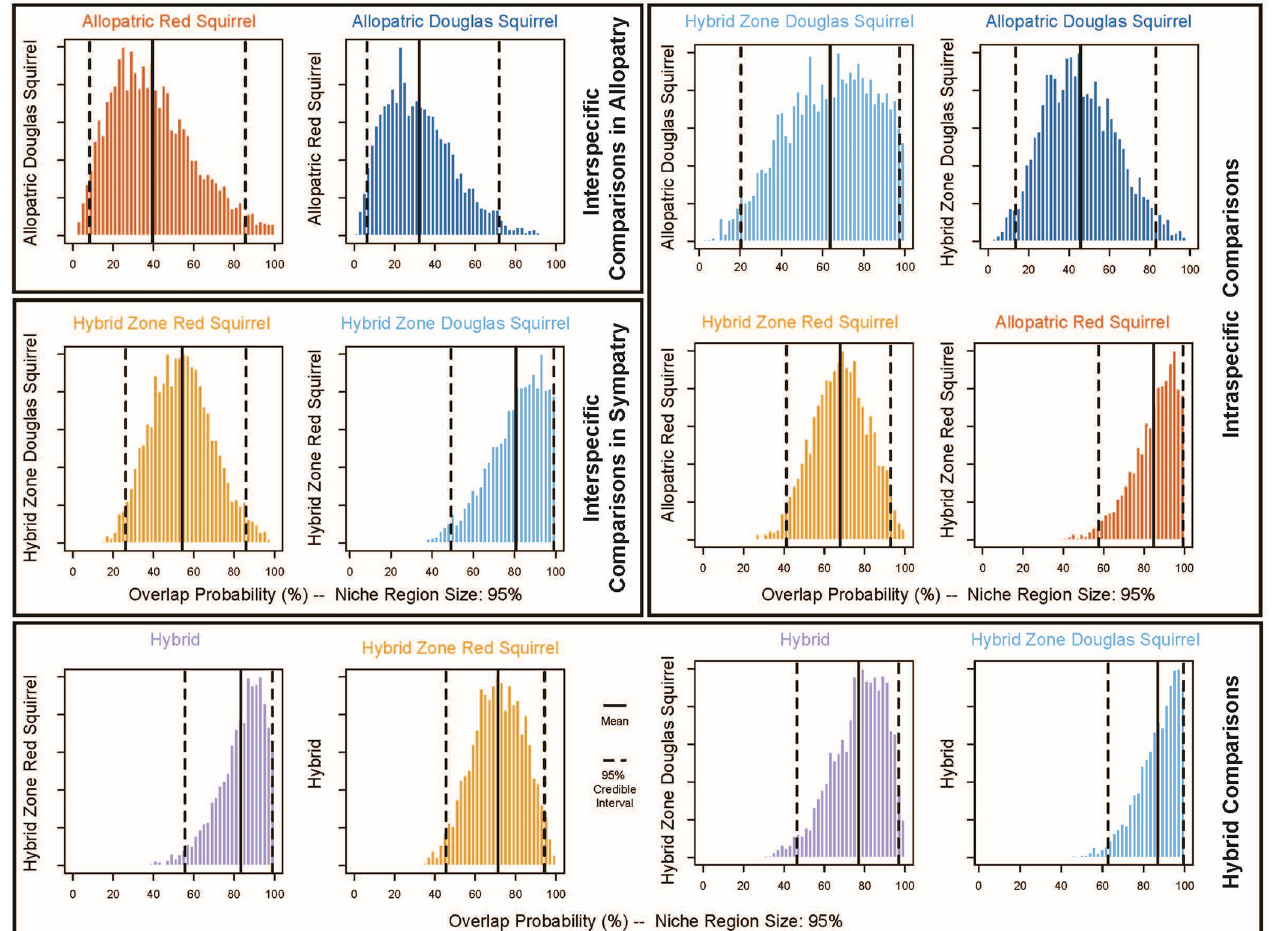
Fig 6. The probability of mandible morphospace overlap between squirrel groups for geometric morphometric principal components 1 and 2 representing shape and log10-transformed centroid size representing size. Data shown are a posterior histogram of 3000 iterations of overlap metric calculations, whereby the x-axis of each pairwise comparison is the range of overlap probabilities in percentage, and the y-axis is the frequency of that probability having been observed in the calculation. Mean overlap probability is shown as a solid black line, and 95% confidence intervals are shown as dashed lines for all pairs. The plots shown here represent key comparisons for this study; additional comparisons are shown in S1 Fig. (nasofrontal: R 2 = 0.01, p = 0.627; premaxillofrontal: R 2 = 0.001, p = 0.879; maxillofrontal: R 2 =